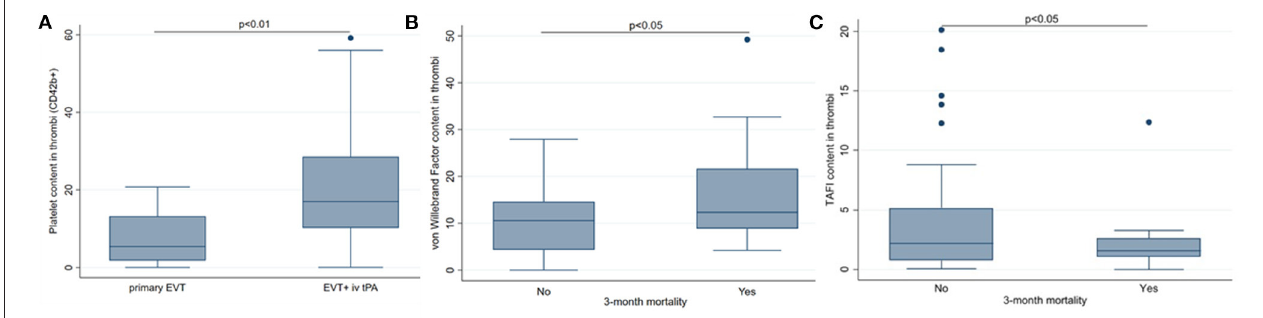
FIGURE 5 | Association of thrombi components with clinical outcomes. (A) tissue plasminogen activator (tPA) treatment was associated with higher platelets (CD42b) content. (B) Patients who died within 3 months had higher von Willebrand Factor. (C) Patients who died within 3 months had lower thrombin-activatable fibrinolysis inhibitor (TAFI) content thrombi. EVT, endovascular treatment. Median (%) and interquartile range (IQR) 25–75, p < 0.05 and p < 0.01 using Chi-square or Fisher’s exact